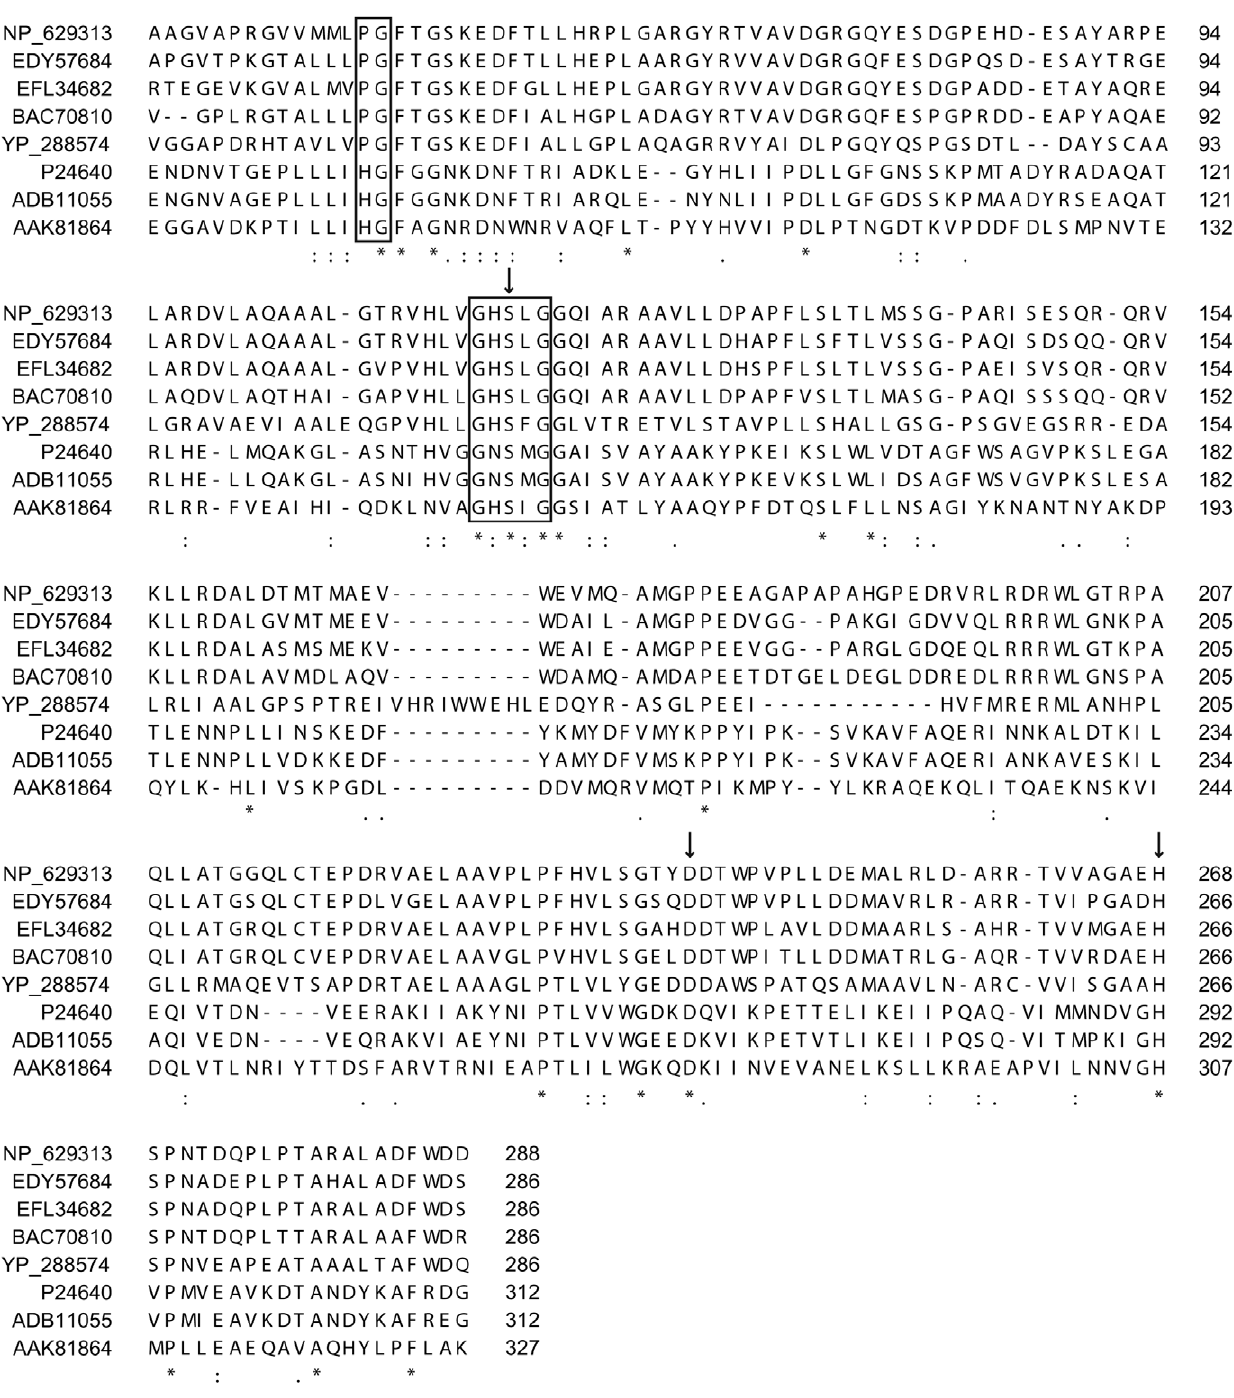
Figure 1. Sequence alignment of EstC with homologous lipases. NP_629313, EstC from S. coelicolor A3(2); EDY57684, putative hydrolase from S. sviceus ATCC 29083; EFL34682, putative hydrolase from S. viridochromogenes DSM 40736; BAC70810, putative hydrolase from S. avermitilis MA- 4680; YP_288574, putative hydrolase from Thermobifida fusca strain YX; P24640, lipase 3 from Moraxella sp.; ADB11055, lipase from Psychrobacter sp. G; AAK81864, lipase from Streptococcus sp. (N1). The conserved Gly-X aa -Ser-X aa -Gly pentapeptide and the proposed oxyanion hole are boxed. Residues of the catalytic triad are shown by arrows. Sequence alignment was performed with TCoffee [52,53].